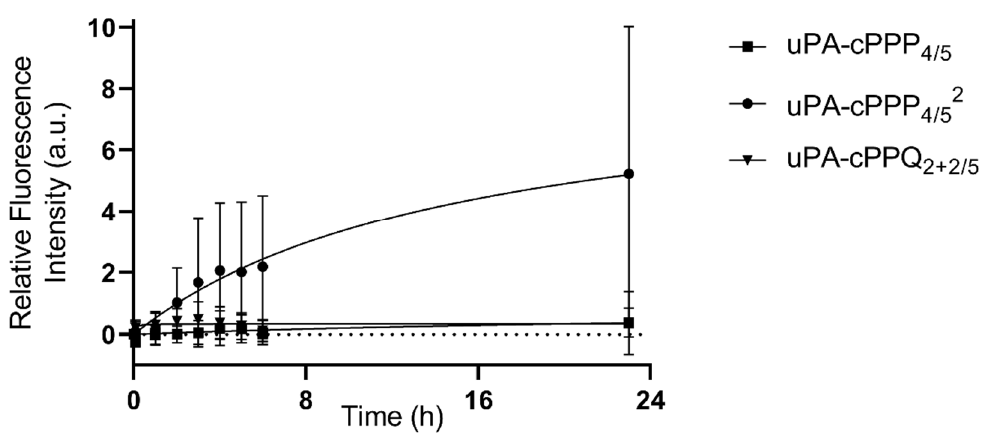
Figure 6. In vivo activation upon proteolytic digestion of uPA-cPPP 4/5 , uPA-cPPP 4/52 or uPA-cPPQ 2+2/5 in A549 spheroids grafted onto hen egg CAMs (injection of 30 µL in NaCl 0.9% at 0.8 mM of Pha eq ; n = 8 to 12; mean ± SD).